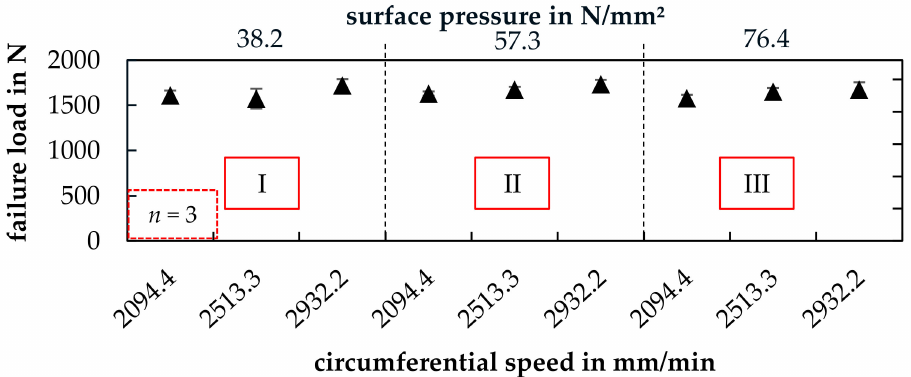
Figure 11. Influence of the process parameters on the failure loads—used tool (Ø10